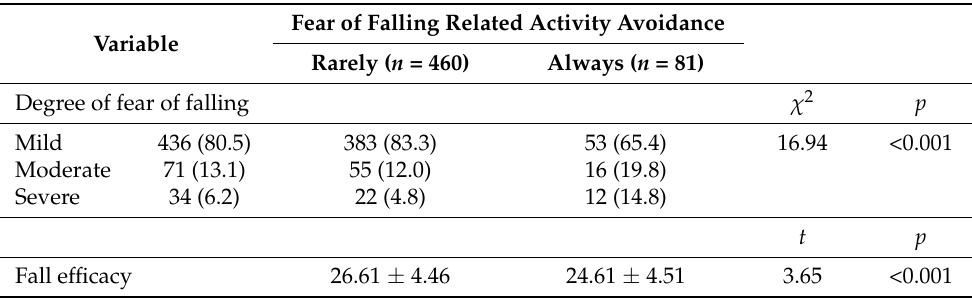
Table 3. Fall efficacy and fear of falling according to fear-related activity avoidance ( N =